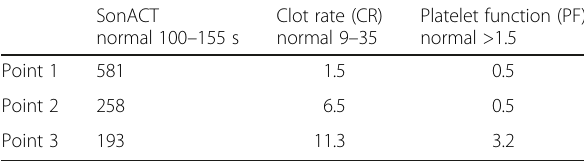
Table 2 Changes in three signatures of Sonoclot® analyzer during the